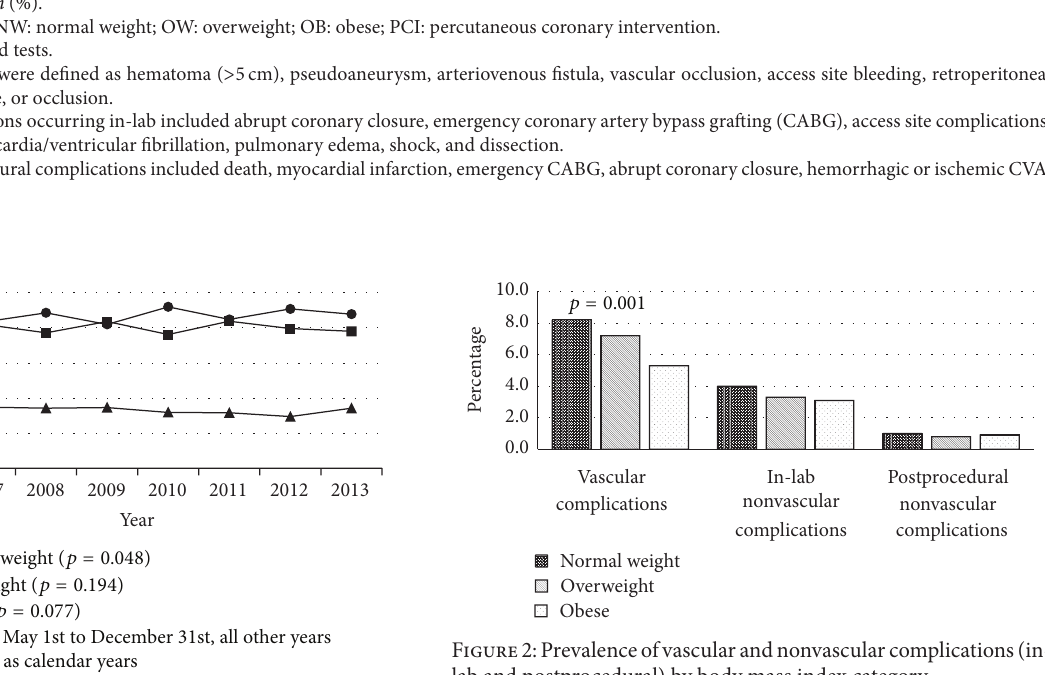
Figure 1: Body mass index trends for normal weight, overweight, and obese patients from 2006 to 2013.